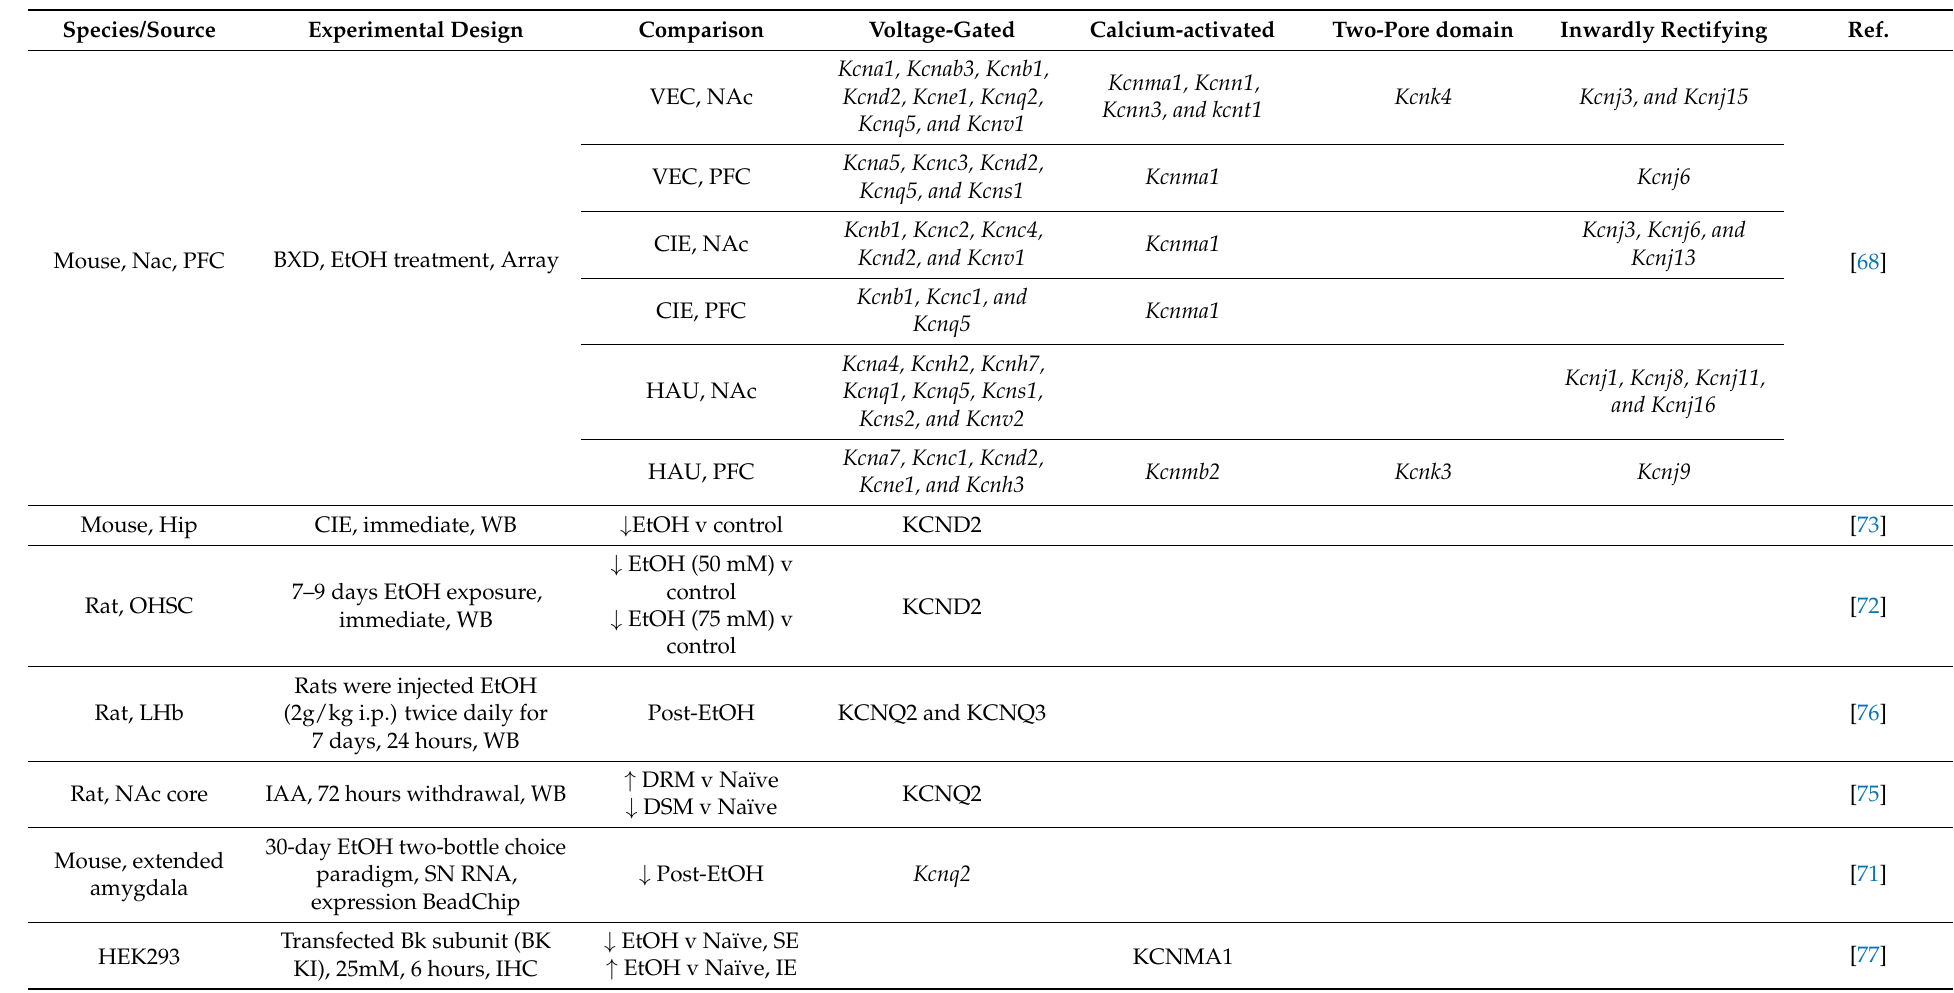
Table 2. Potassium Channels Effected by